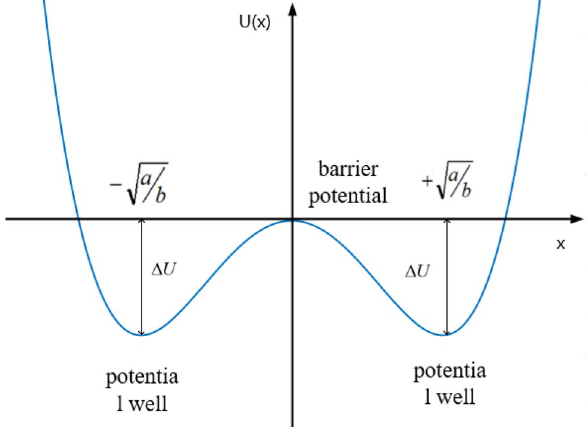
Fig. 2 Potential function of nonlinear bistable